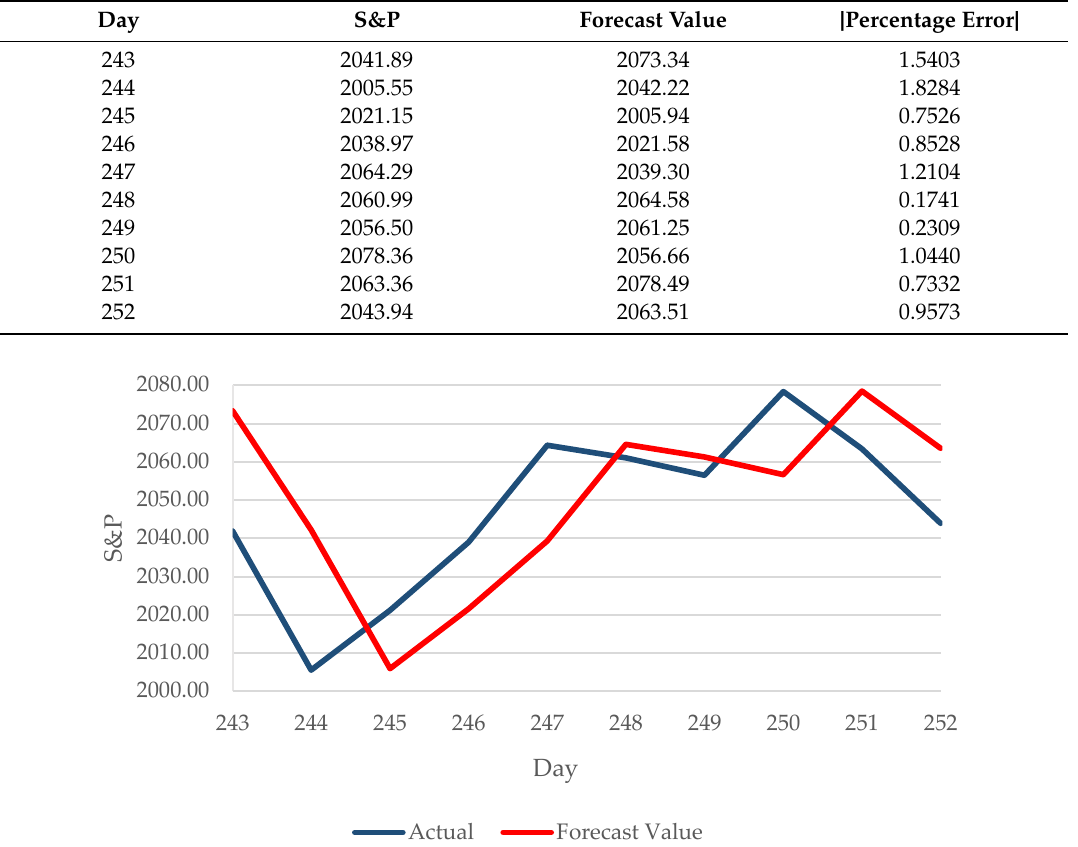
Figure 5. Plot of the actual data and the forecast values.